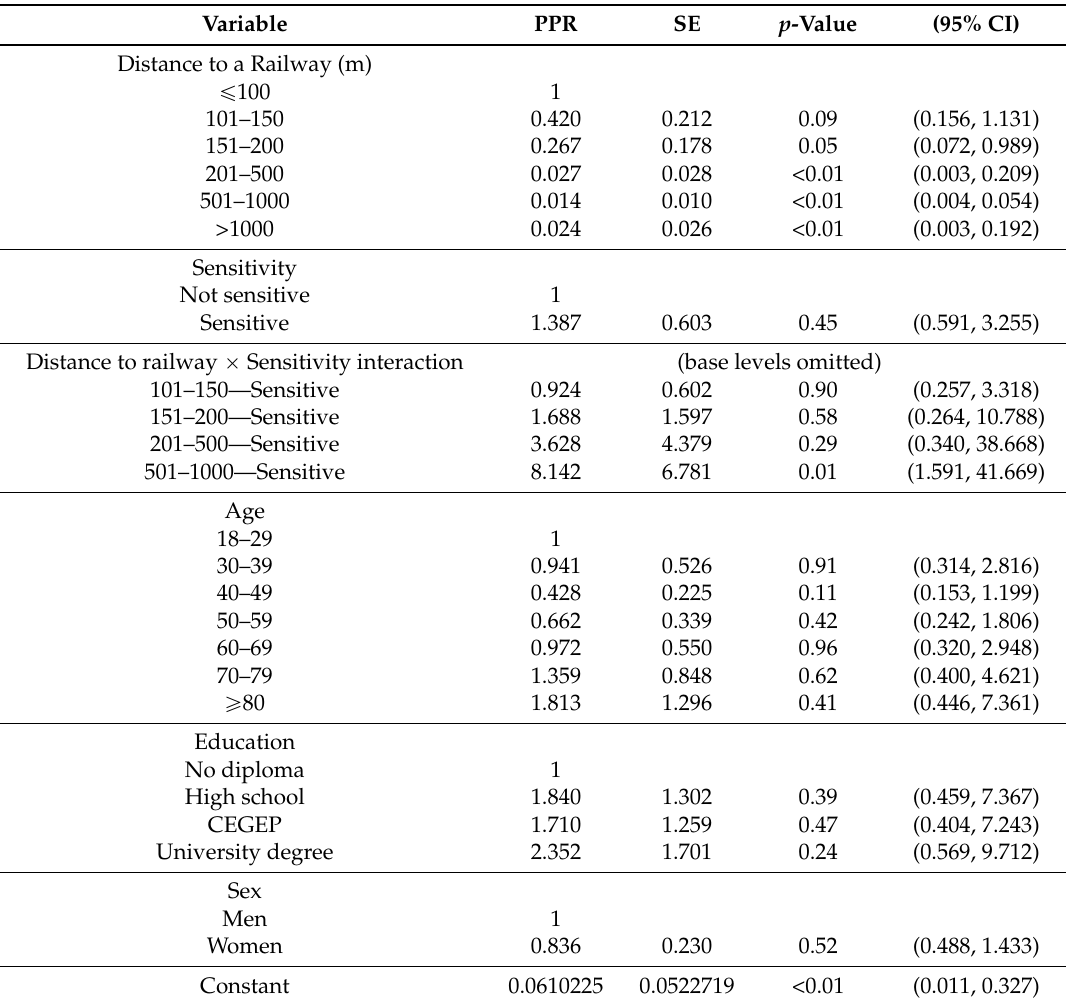
Table A4. Distance to railways and proportions of sleep disturbance due to railways in the weighted study sample, adjusted for sensitivity to noise: regression model.